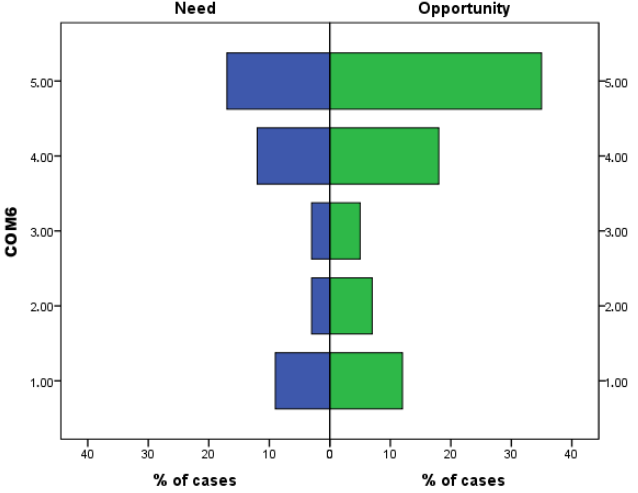
Figure 9. Barplot of COM6 (previous start-up experience of the founders) split per need and oppor- tunity.